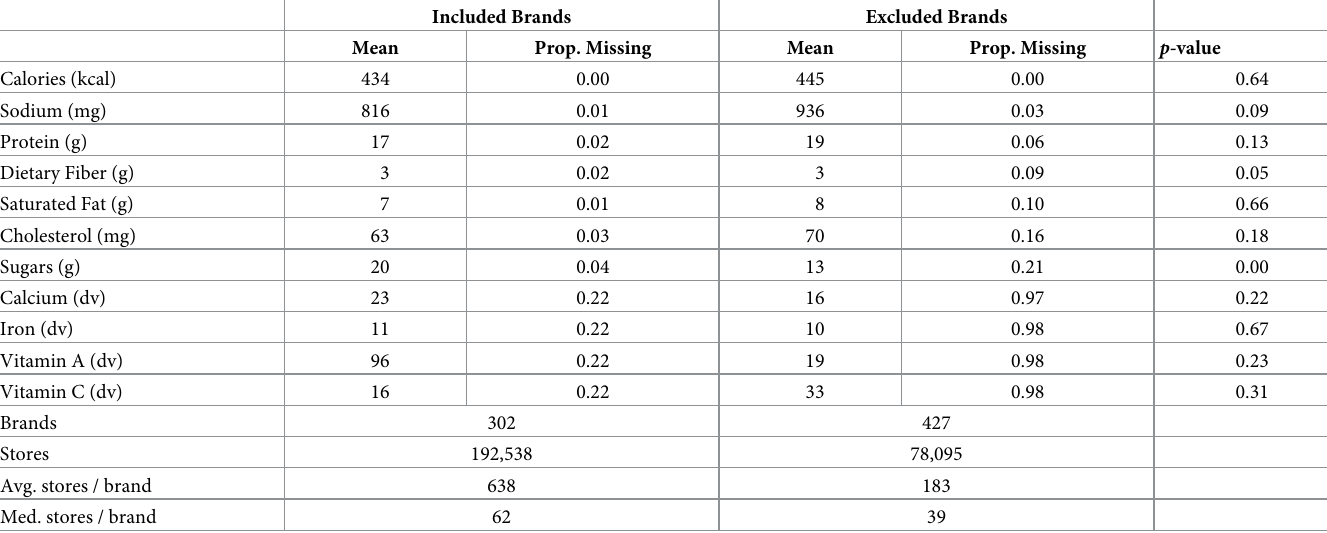
Table 1. Nutrition statistics of brands included and excluded from analysis.